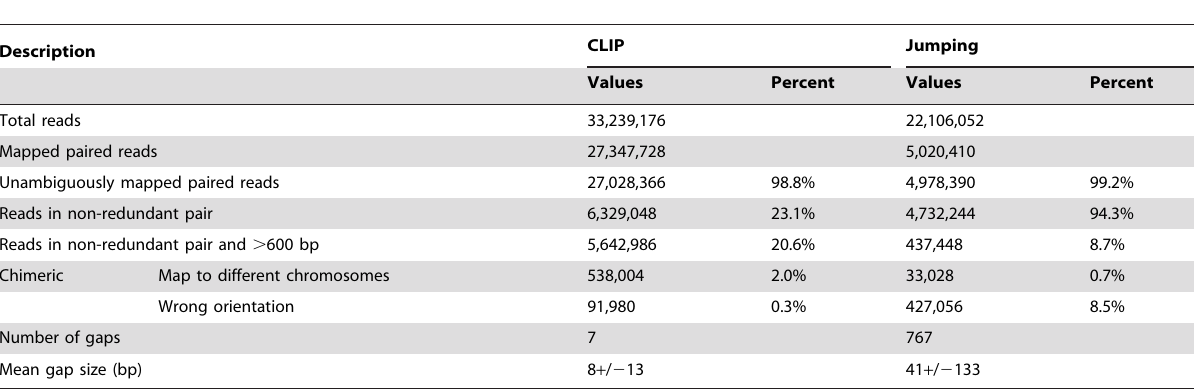
Table 1. Results from the alignment of Haloterrigena turkmenica VKM, DSM 5511 5 kb mate pair libraries made with CLIP-PE method and Illumina Jumping method to the reference